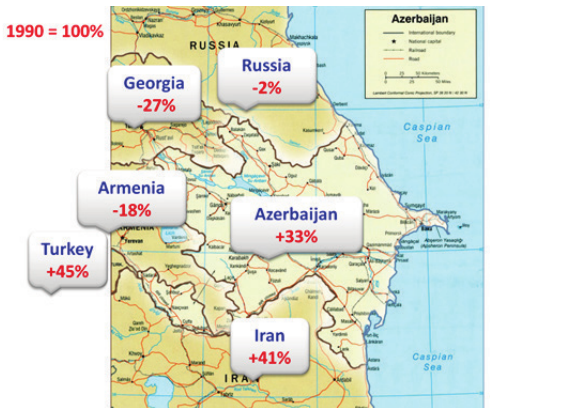
Figure 2. Population growth in Azerbaijan and neighbouring countries (1990-2015). Source: based on UN Population Prospects (medium variant) data (UN Population